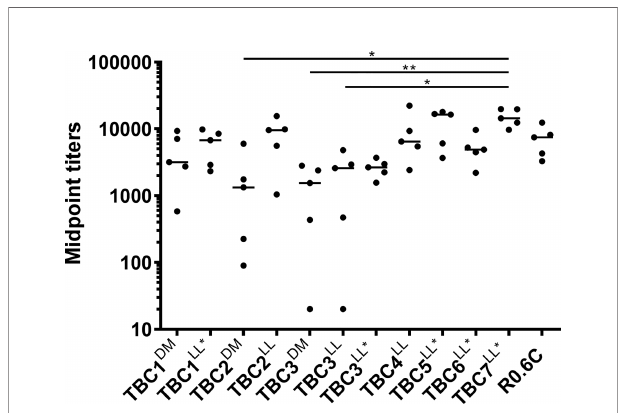
FIGURE 3 | Immunogenicity of antigens in mice. Mice were immunized three times with 10 µg formulated in Montanide ™ ISA720. Midpoint titers (EC50) values of individual mice sera (n=5) from the fi nal bleed (day 56) analyzed in recombinant antigen ELISA against immunogen. Median values per group are shown as bars. Midpoint titers were calculated using sigmoidal curve fi tting. For one mouse in TBC3 DM and one in TBC3 LL we could not fi t a curve due to low levels of antibodies, and the midpoint titers were therefore arbitrarily set to 20. Names with * indicate antigens that were expressed as R0 chimeras. Differences between groups were tested for statistical signi fi cance the non- parametric Kruskal-Wallis test and Dunn ’ s multiple comparison post-test. Statistically signi fi cant differences are indicated in the fi gure (*<0.05, **<0.01), absence of symbols indicated no statistical signi fi